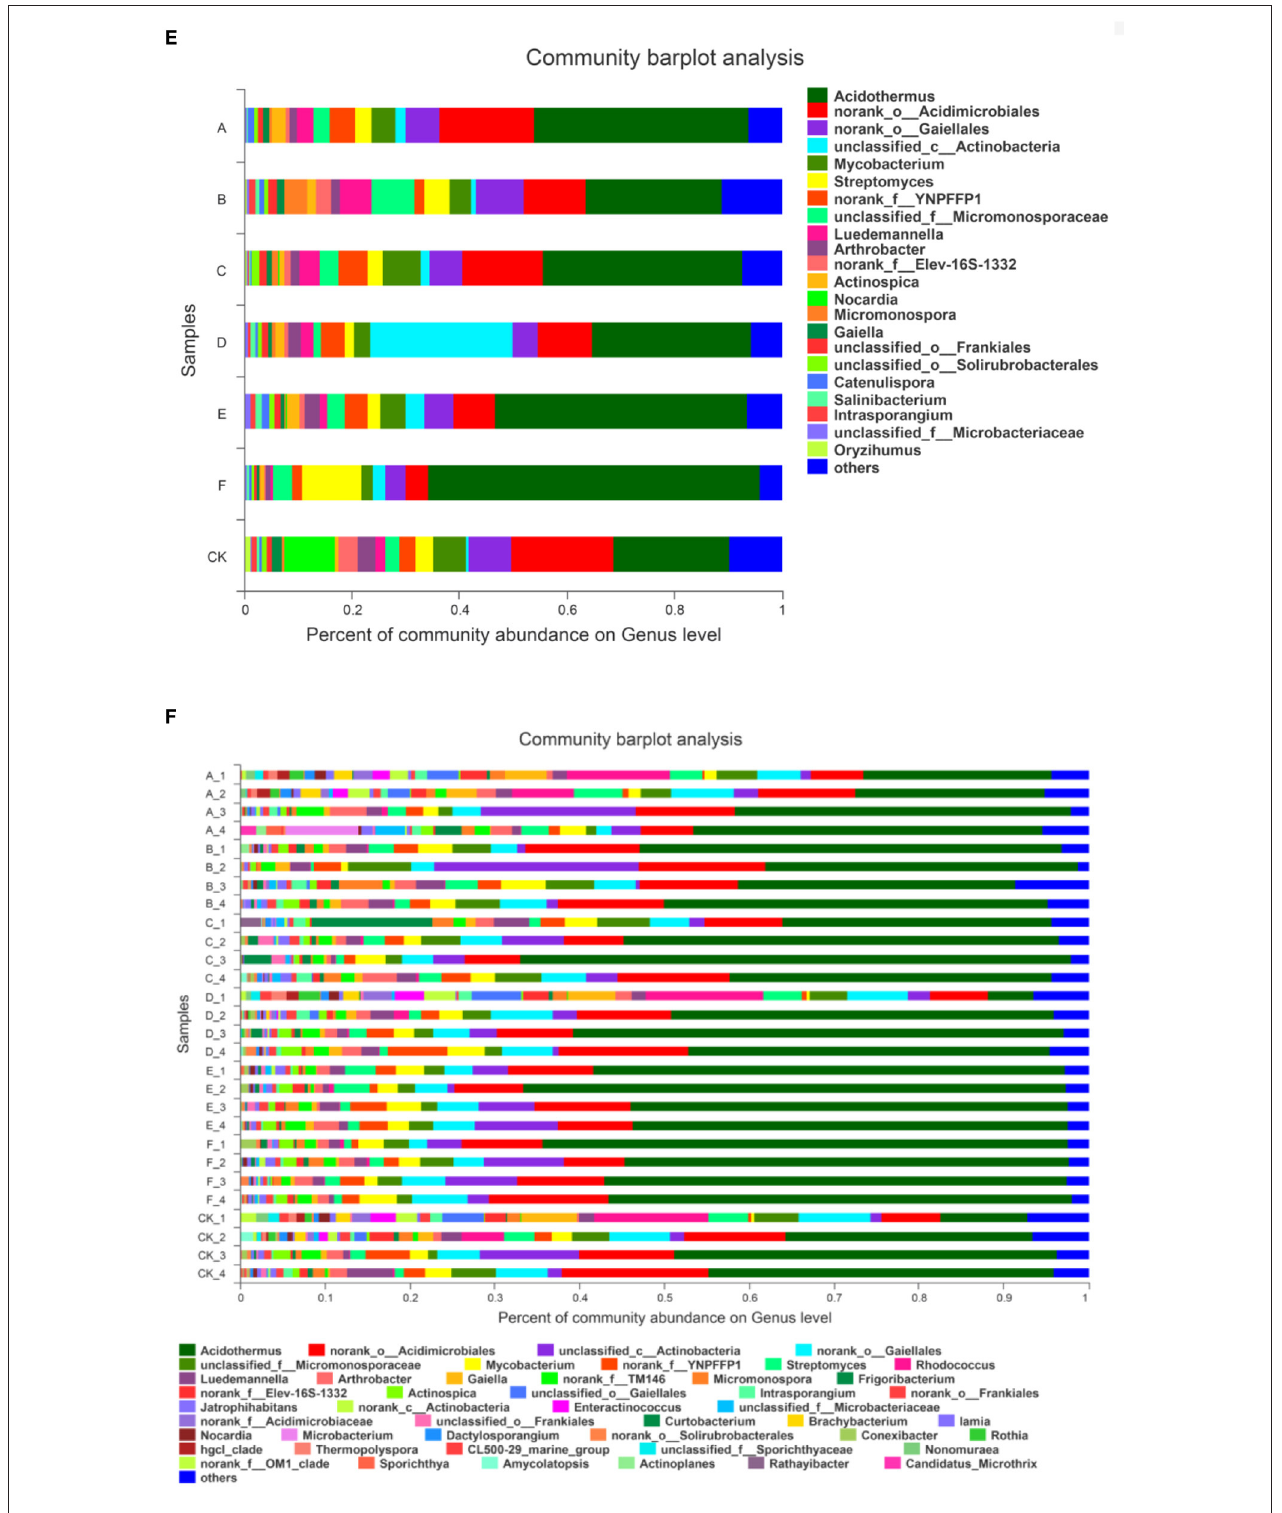
FIGURE 3 | The horizontal abundance of microorganisms in kiwifruit soil after sulfur treatments. (A,B) bacteria; (C,D) fungi; (E,F) actinomycetes. A: 0.5 kg/m 3 sulfur powder + 10kg organic fertilizer; B: 1 kg/m 3 sulfur powder + 10kg organic fertilizer; C: 1.5 kg/m 3 sulfur powder + 10kg organic fertilizer; D: 2.0 kg/m 3 sulfur powder + 10kg organic fertilizer; E: 2.5 kg/m 3 sulfur powder + 10kg organic fertilizer; F: 3.0 kg/m 3 sulfur powder + 10kg organic fertilizer; CK: only 10kg organic fertilizer. The same below.